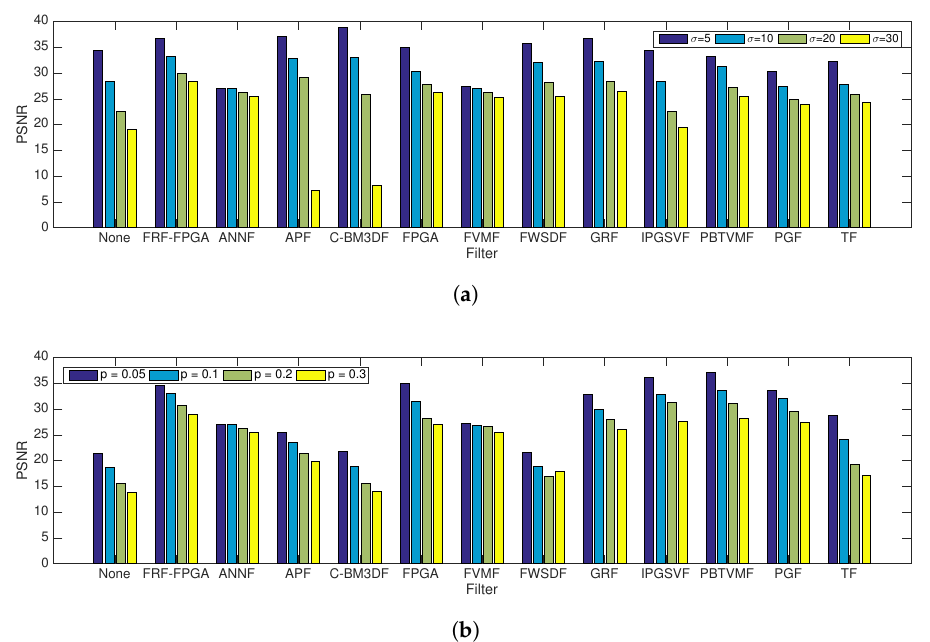
Figure 9. Comparison of PSNR obtained by state-of-the-art methods when restoring Lena contaminated only with Gaussian noise σ or impulse noise p . ( a ) Lena contaminated only with Gaussian σ . ( b ) Lena contaminated only with impulse p .